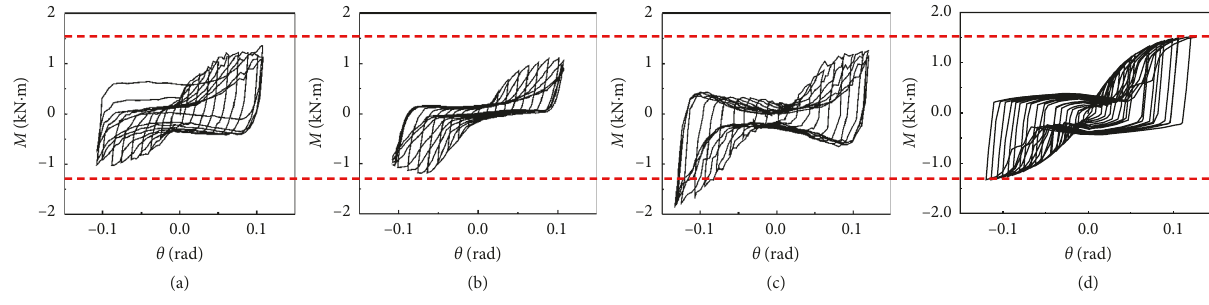
Figure 12: Hysteresis curves of (a)–(c) reference tests and (d) simulation.